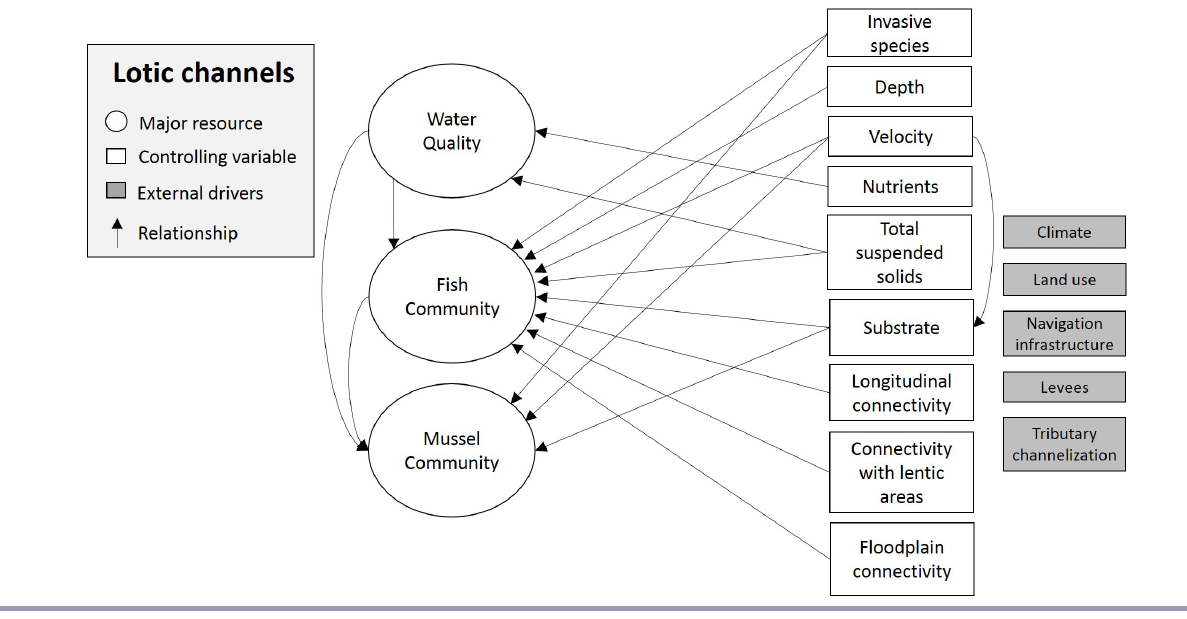
Fig. 5 . Major resources identified for lotic channels represent valued ecosystem services and include water quality, fish community, and mussel community. Nine controlling variables, or dominant factors, that affect major resources were identified to influence these major